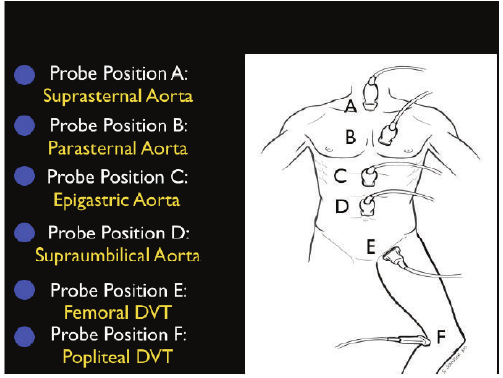
Figure 23: The RUSH exam. Step3: Evaluation of “the pipes”.